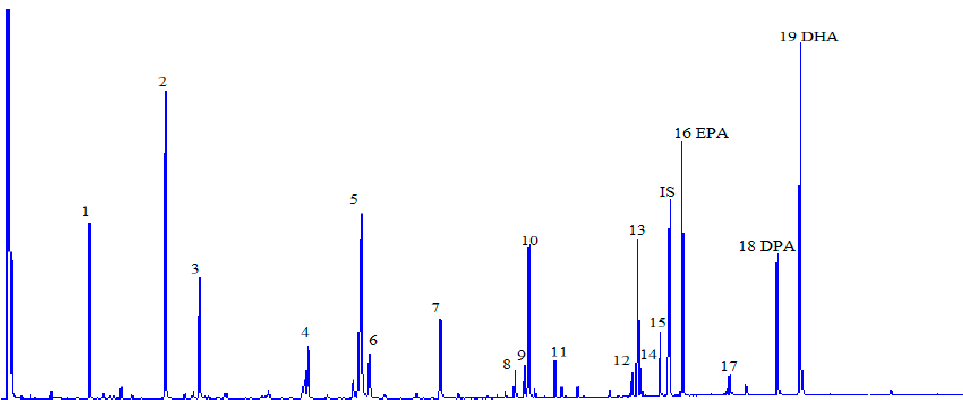
Figure 1. Chromatogram of fatty acid methyl ester (FAME) analysis of lipids extracted from salmonid fish fillets; example of wild salmon (Baltic): 1—C14:0; 2—C16:0; 3—C16:1; 4—C18:0; 5—C18:1n-9; 6—C18:1n-7; 7—C18:2n-6; 8—C18:3n-